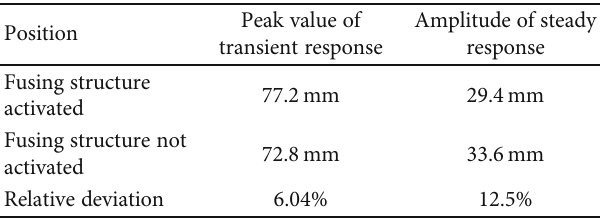
Table 5: Response value of a dual-rotor system with varied-sti ff ness fusing structure.